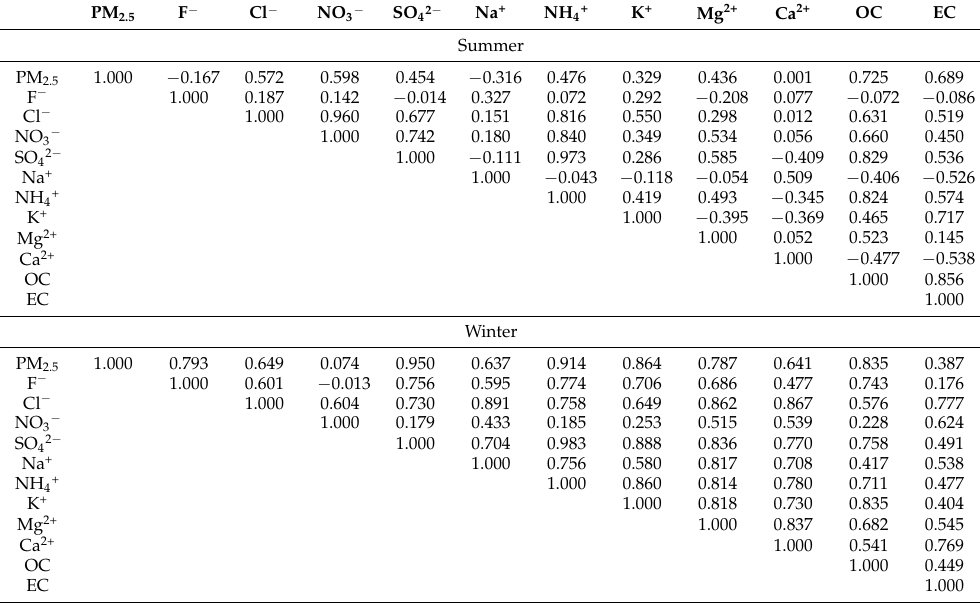
Table 3. Pearson correlation coefficients among PM 2.5 chemical compositions measured during the summer and winter